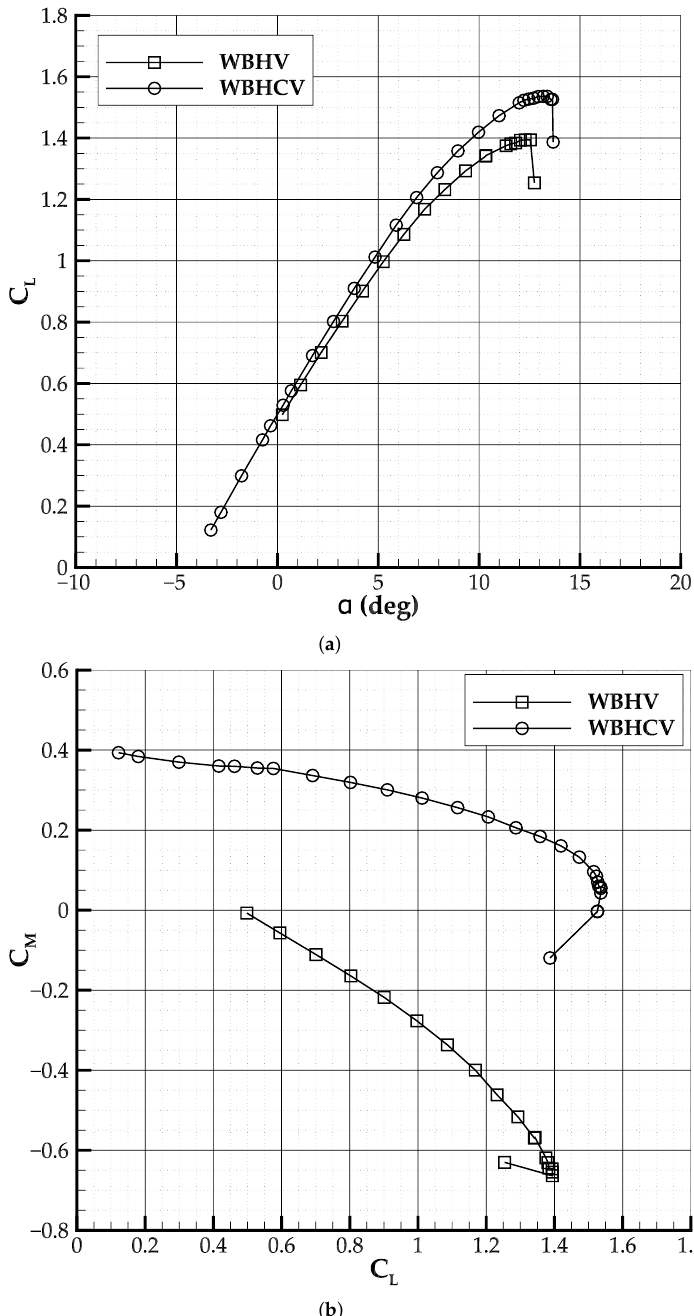
Figure 13. Wind tunnel results. Reference point at x CG = 0, V = 35m/s, Re = 315,000. ( a ) Effect of the canard on the complete aircraft lift curve; ( b ) comparison of longitudinal stability curves for configuration with and without